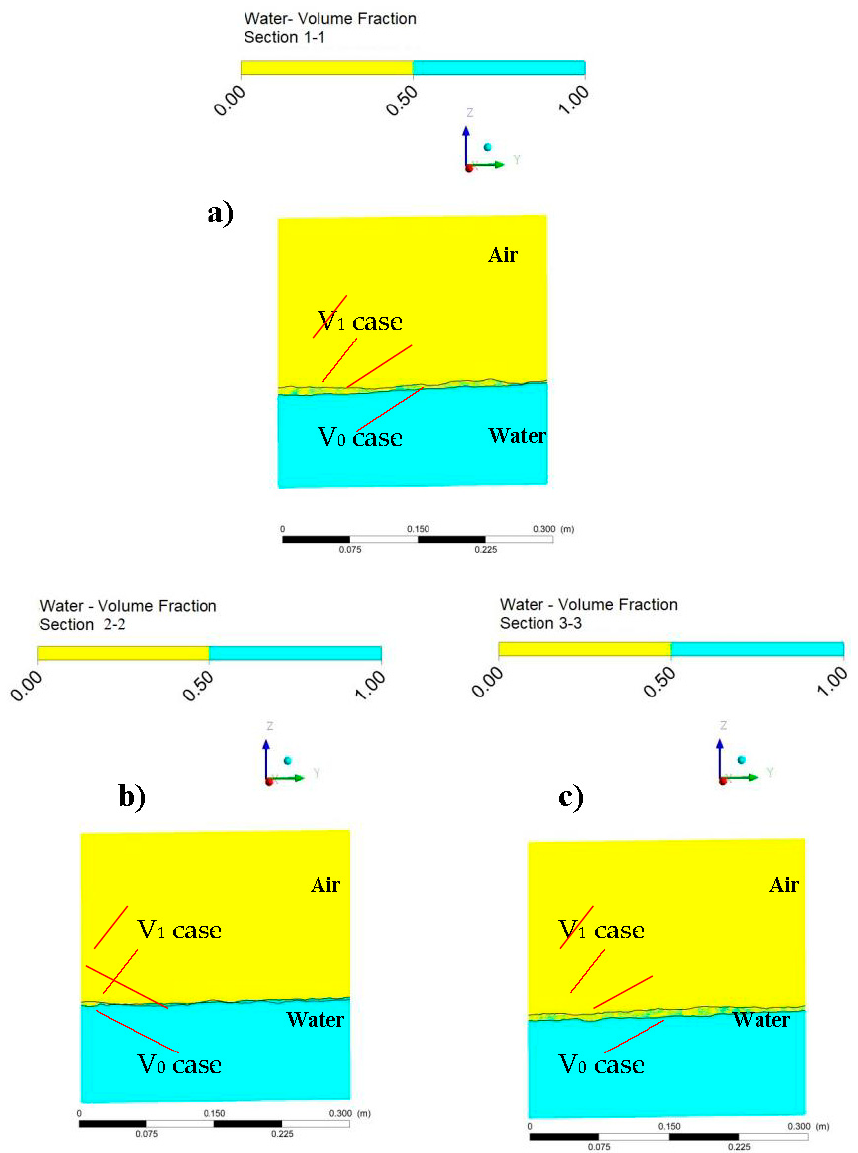
Figure 11. CFD -water level changes (m) in V 0 and V 1 case at ( a ) 1-1, ( b ) 2-2, ( c ) 3-3 sections.